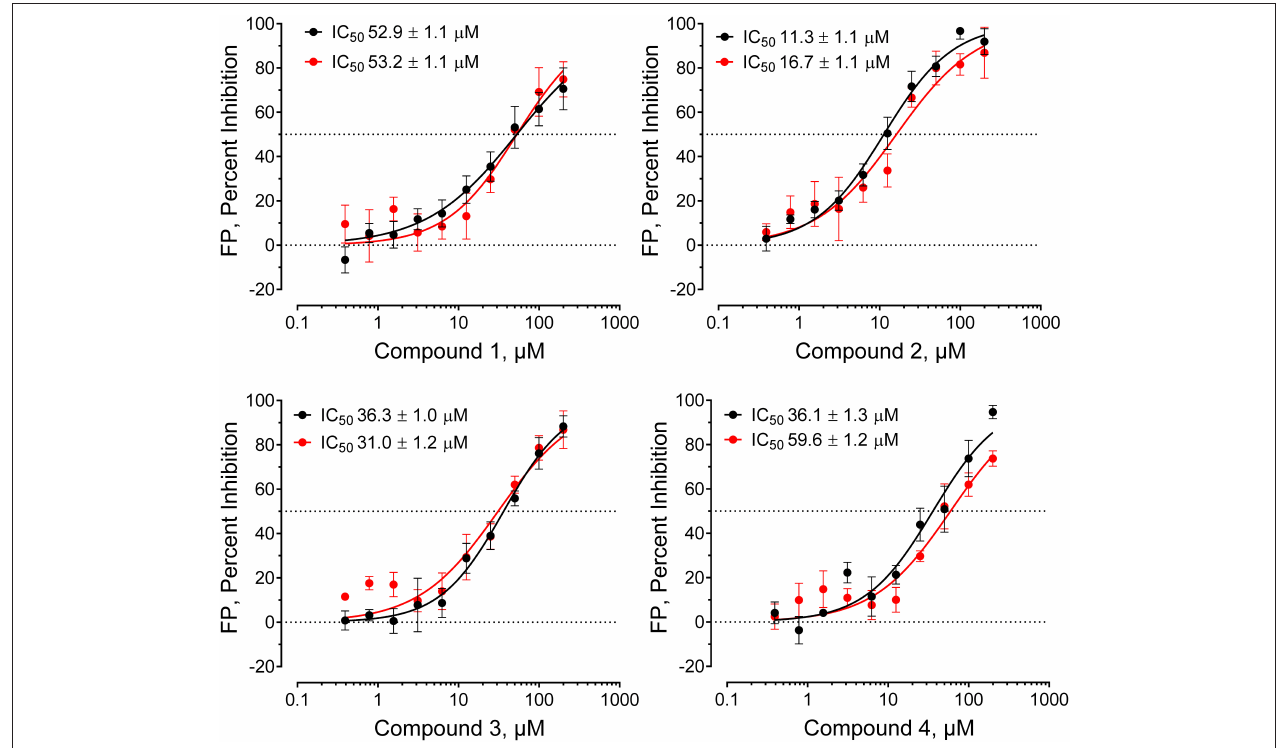
FIGURE 3 | Hck-binding compounds inhibit Hck-U32L target protein interaction with the VSL12 probe peptide in a concentration-dependent manner. Four confirmed hit compounds from the FP screen of the ChemBridge 50,000 compound library were purchased as powders, and re-tested in the screening assay over a wide range of concentrations as shown ( n = 2; each data point in triplicate). The IC 50 values from each of the two determinations ± S.E. are shown at the top left in each